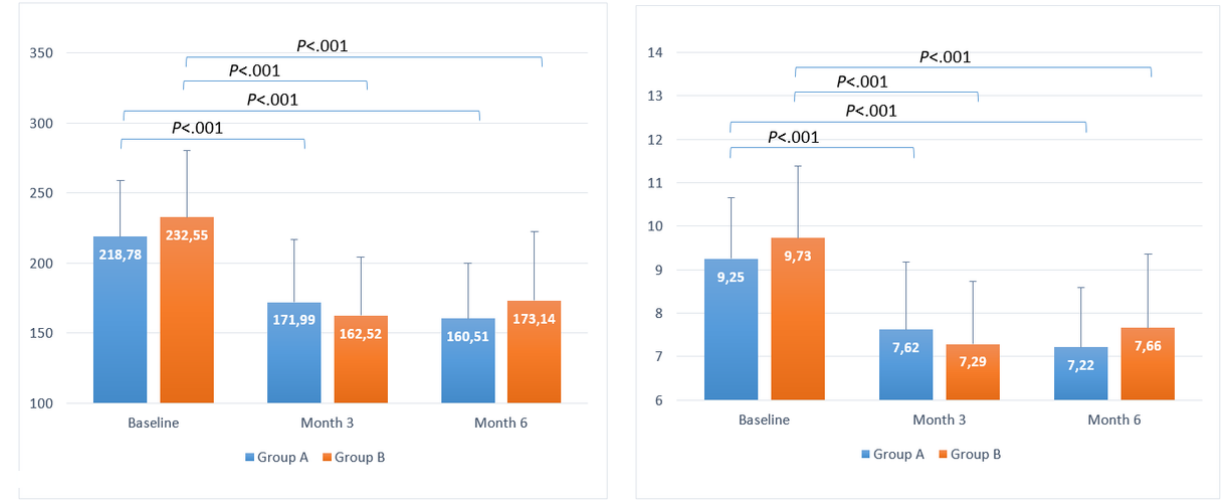
Figure 3. Timeline evolution of estimated blood glucose (left) and estimated glycated hemoglobin (right) for users with type 2 diabetes mellitus.